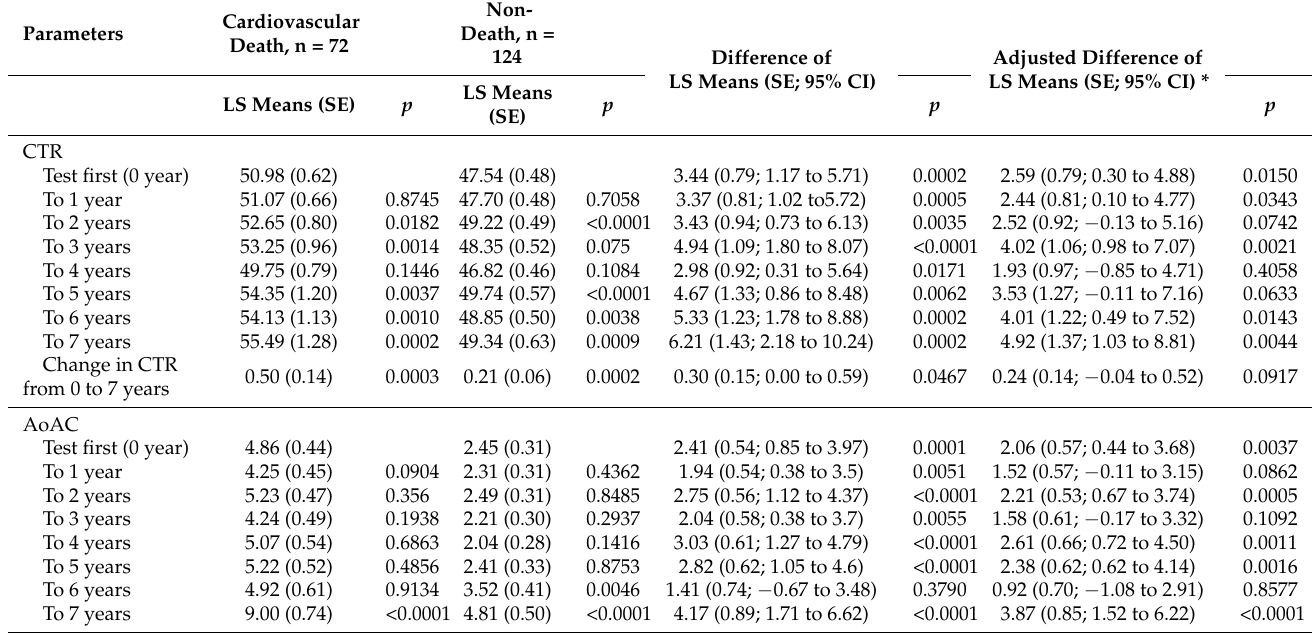
death groups did not achieve significance ( p = 0.0917).